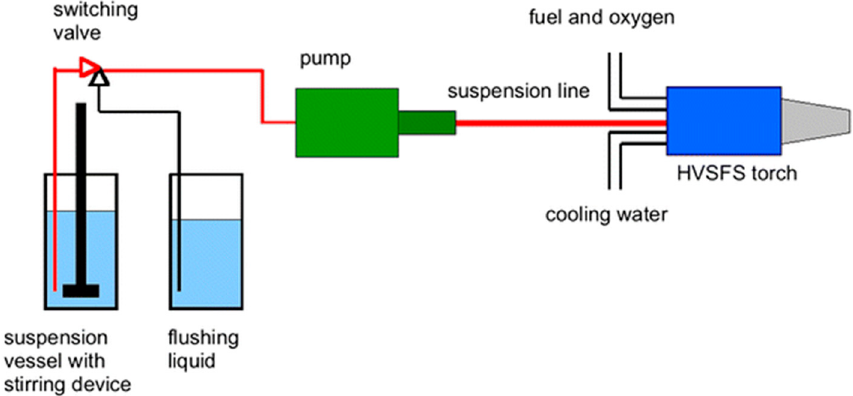
Figure 3. Schematic illustration of a high-velocity suspension flame-spray (HVSFS) experimental setup for nano-oxide ceramic coatings [73].